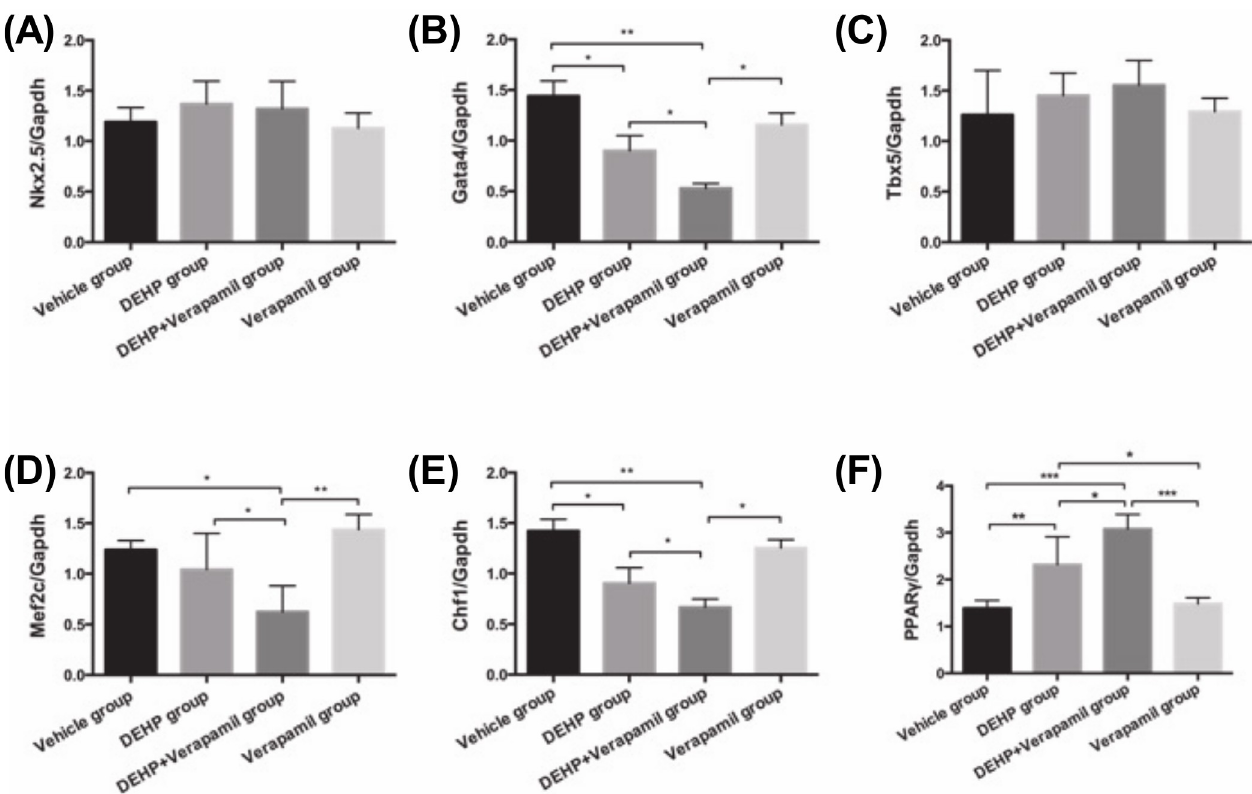
Fig 4. Effect of maternal Di-(2-ethylhexyl)-phthalate (DEHP) and verapamil exposure from E6.5 to E14.5 on fetal heart PPAR γ /Nkx2 . 5/Gata4/Tbx5/ Mef2c/Chf1 mRNA expression at E15.5. Differences among different groups were determined by ANOVA followed by a Student–Newman–Keuls multiple comparisons. N = 10, 15, 20 and 10 for vehicle, 500mg/Kg DEHP, 500mg/Kg DEHP & 3mg/Kg verapamil and 3mg/Kg verapamil group, respectively. Data were expressed as Means ± SEM. � P < 0.05, �� P < 0.01, ��� P < 0.001 in comparison with the verapamil group and the vehicle